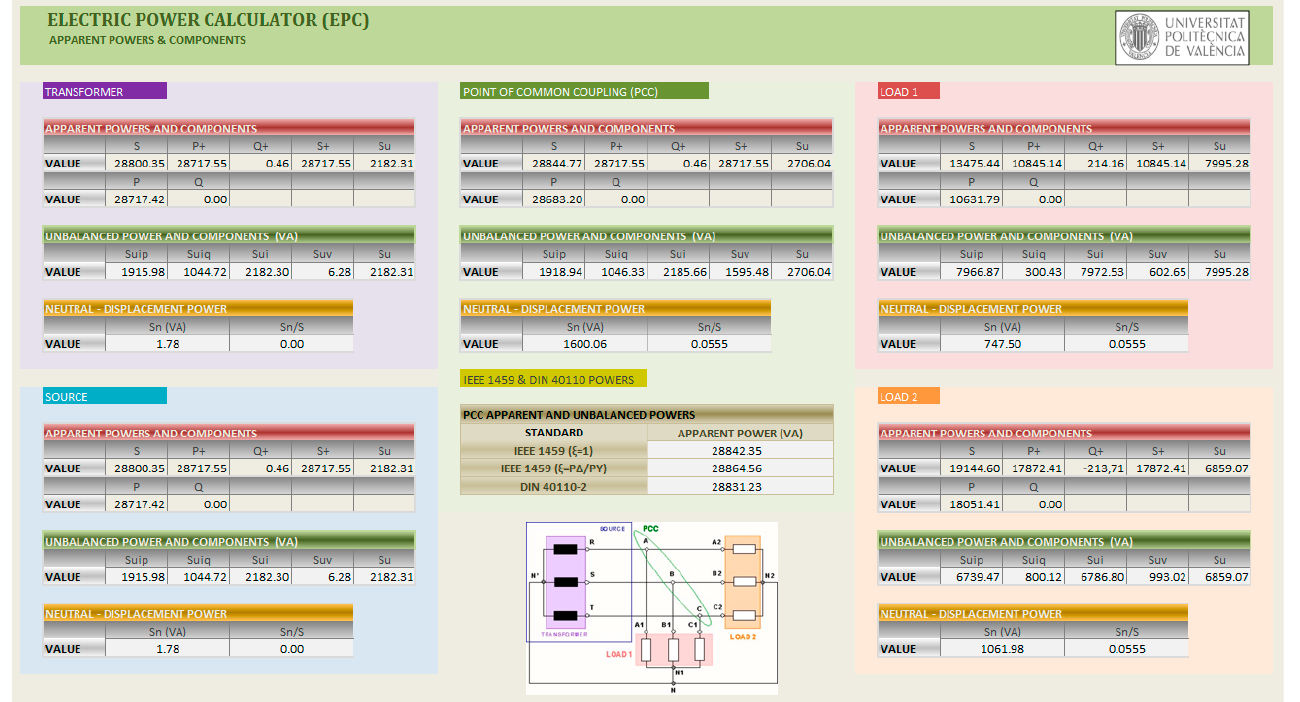
Figure 3. Screen of “Apparent Powers and Components”.